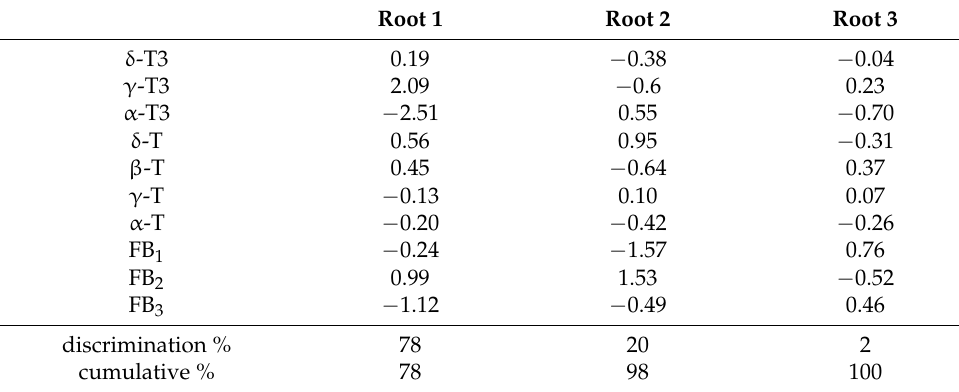
Table 3. Standardized canonical discriminant function coefficients. Root 1 Root 2 Root